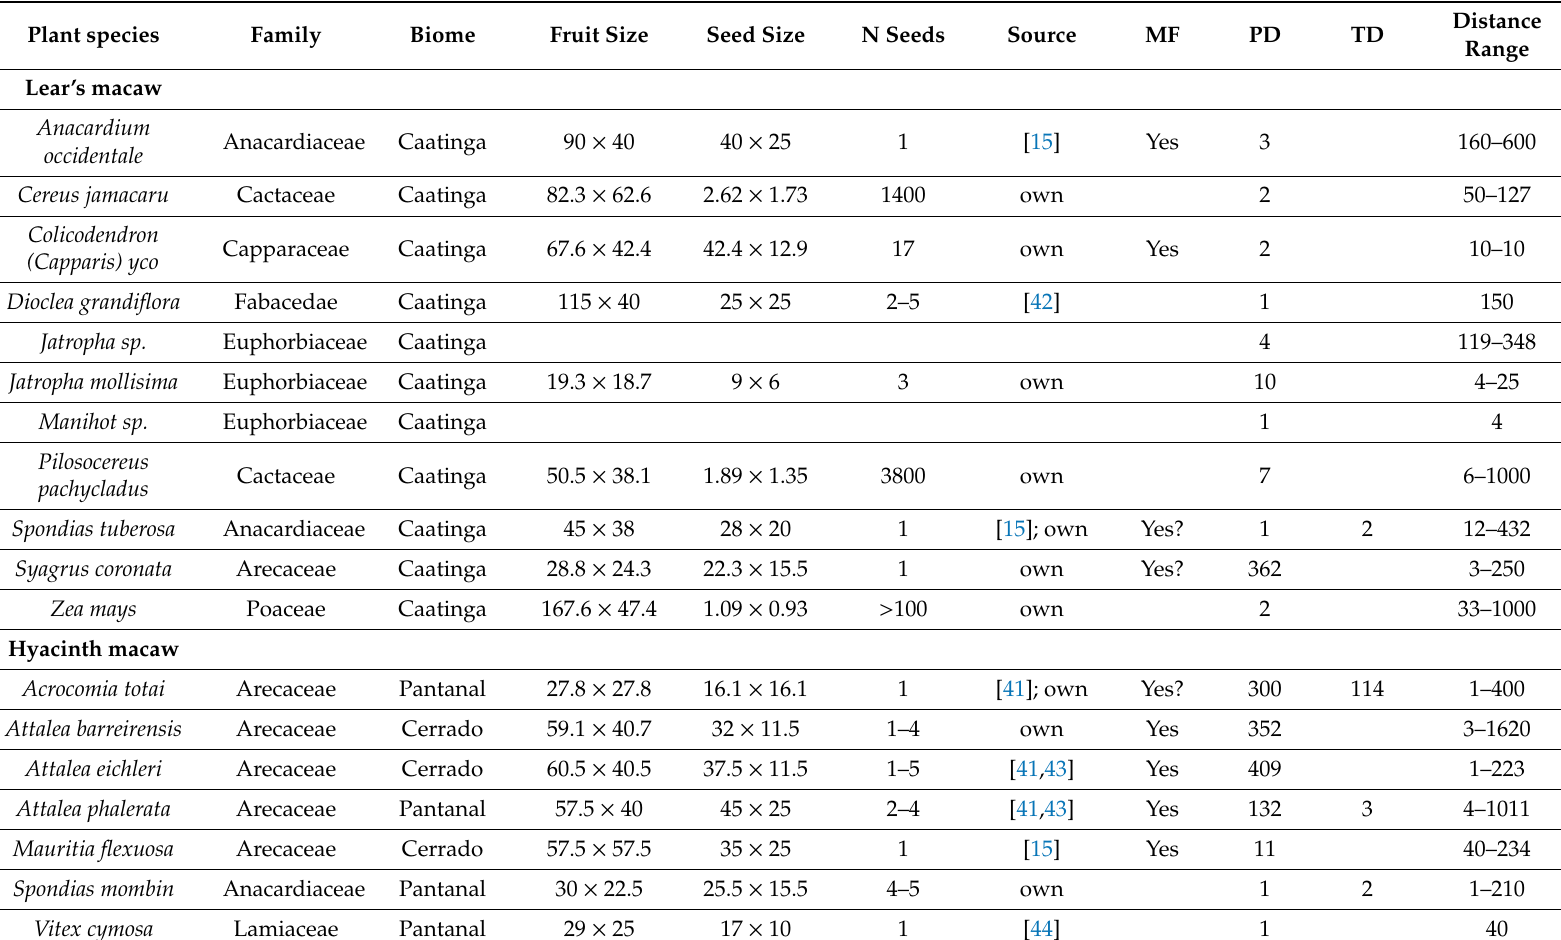
Table 2. Plant species dispersed by hyacinth and Lear’s macaws in the three studied biomes, size of their fruits and seeds (in mm), number of seeds by fruit, and number of primary (PD) and tertiary (TD) dispersal events with the range of dispersal distances observed (in m). Fruits considered as megafauna-dependent type I fruits (MF, following [15]) are indicated (see results for uncertainty for some